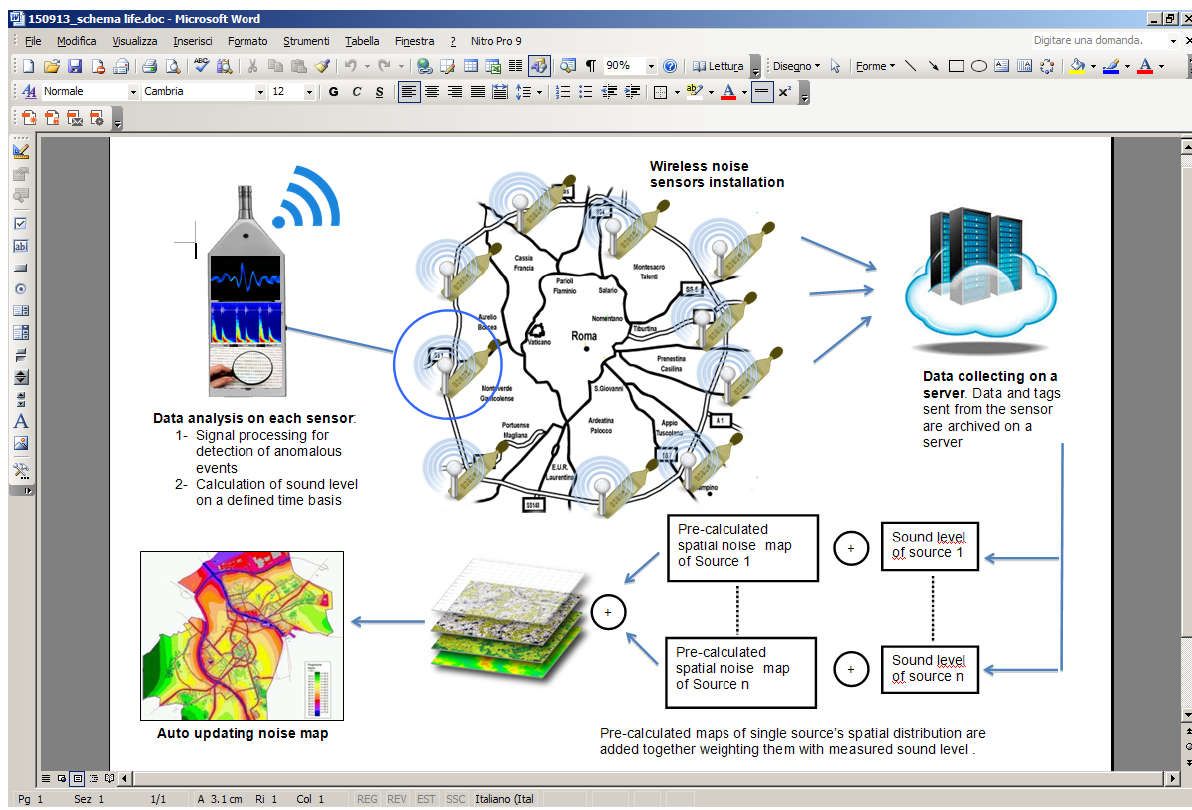
Figure 11: DYNAMAP working